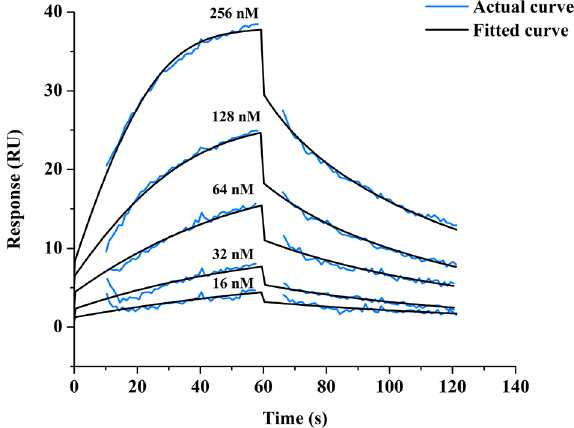
Figure 2. Surface plasmon resonance (SPR) analysis showing binding kinetics of Hepatitis B Surface Antigen (HBsAg) with molecule 5. Kinetic analysis of HBsAg-Molecule 5 binding was performed by injecting different known concentrations of molecule 5 (from 16 to 256 nM) over HBsAg immobilized carboxymethyl dextran- coated CM5 sensor chip (Amine-coupling chemistry). All measurements were performed at 25 °C with a flow rate of 30 μL/min using HBS-EP buffer with association time 60 s followed by 60 s dissociation phase. Kinetic constants were calculated from the sensorgrams using the 1:1 fit model using BIA Evaluation 2.0.1 (Cytiva) software. The blue line indicates the actual curve and black line indicates the fitted curve of the